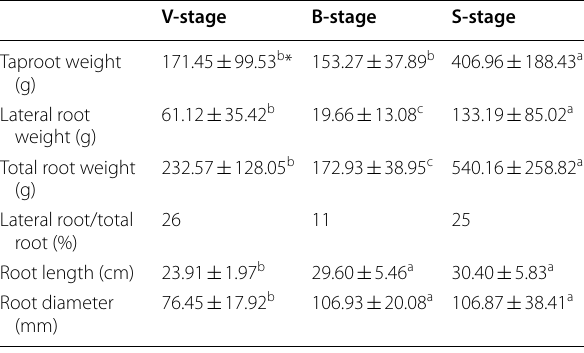
Data are mean SD of 10 independent ±